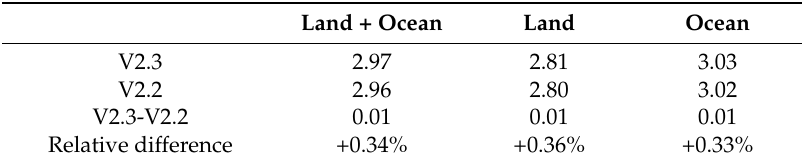
Table 5. Mean precipitation (P, mm day − 1 ) between 40 ◦ N and 40 ◦ S from GPCP V2.3 and V2.2 and their differences from 2003–2008.